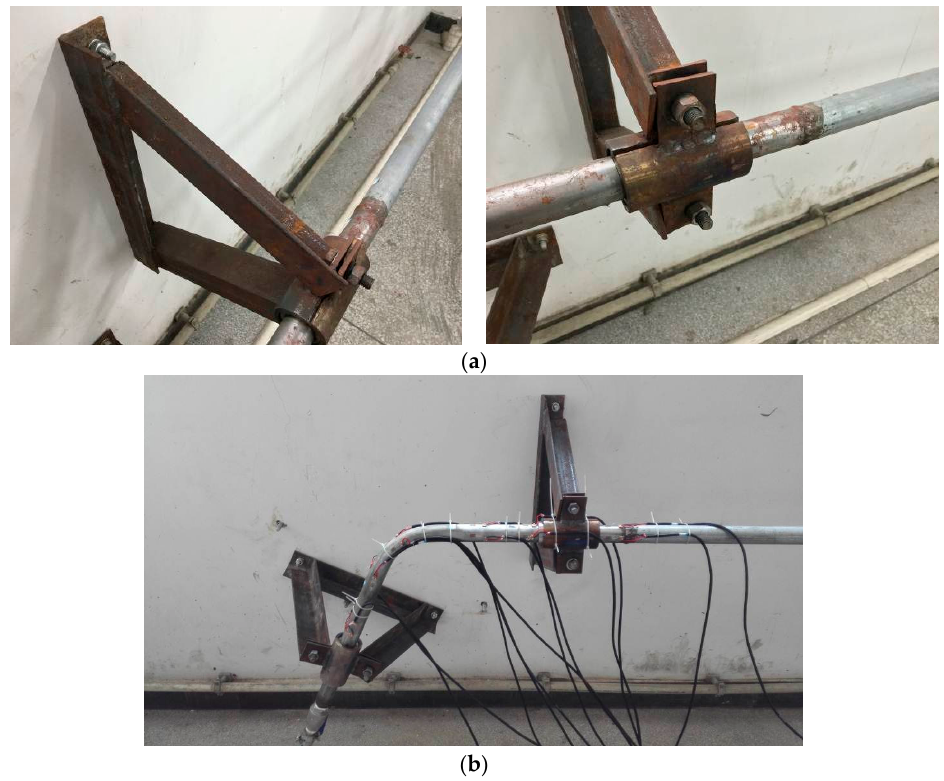
Figure 8. Physical map of clamped supported constraints: ( a ) straight pipe section; ( b ) elbow pipe section.